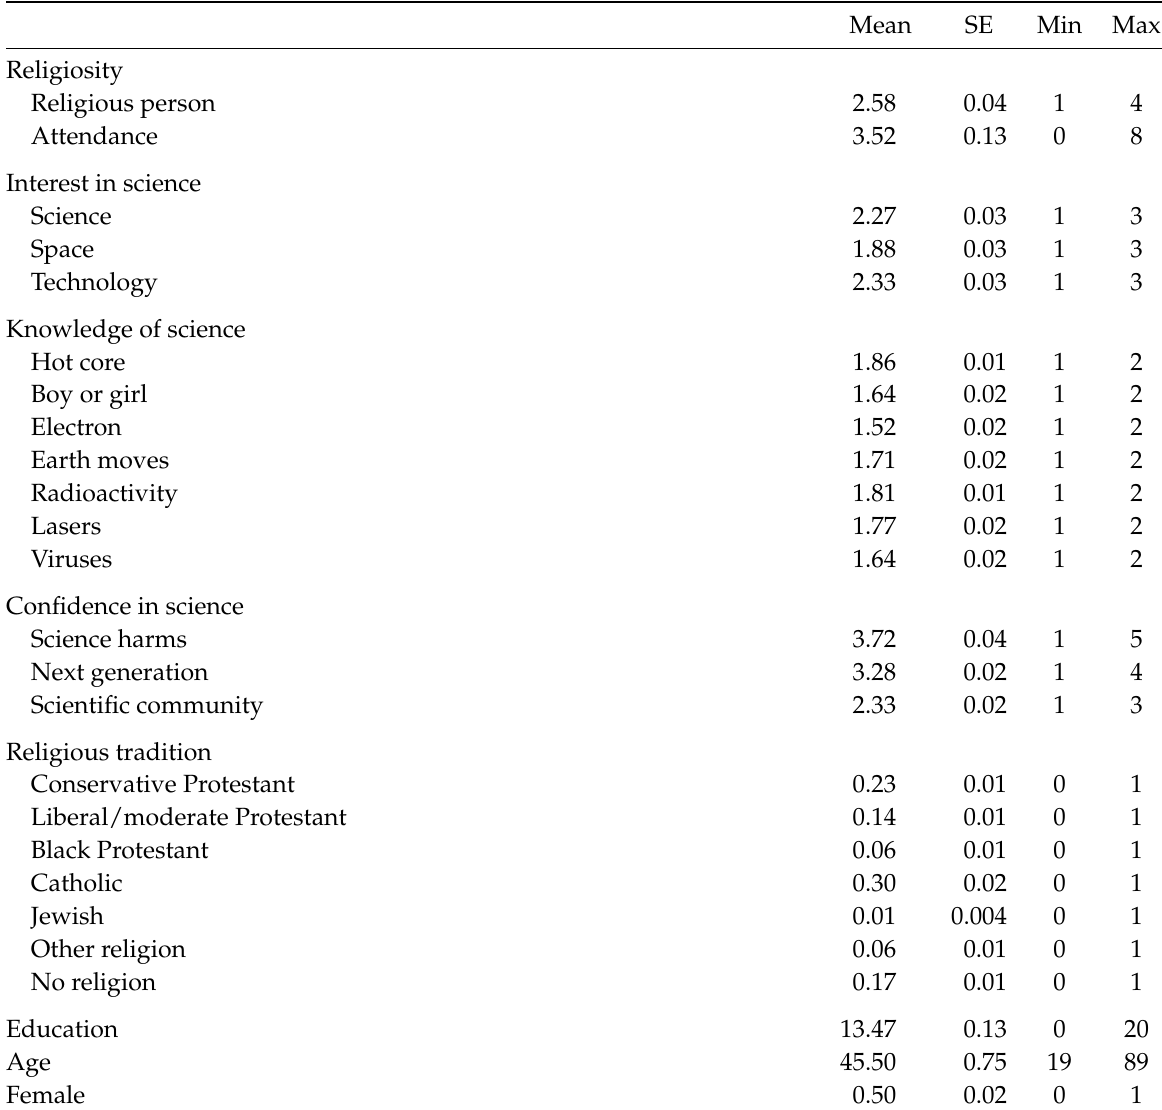
Table 1: Descriptive Statistics for Observed Measures Used in Analytical